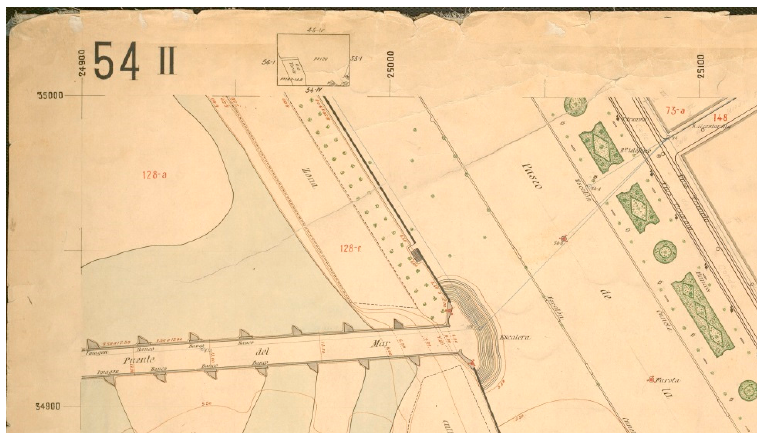
Figure 2. Grid frame corner of the map number 54 II. The X axis and the Y axis show the local coordinates, on this image from 24,900 to 25,100 m and from 35,000 to 34,900 m respectively.